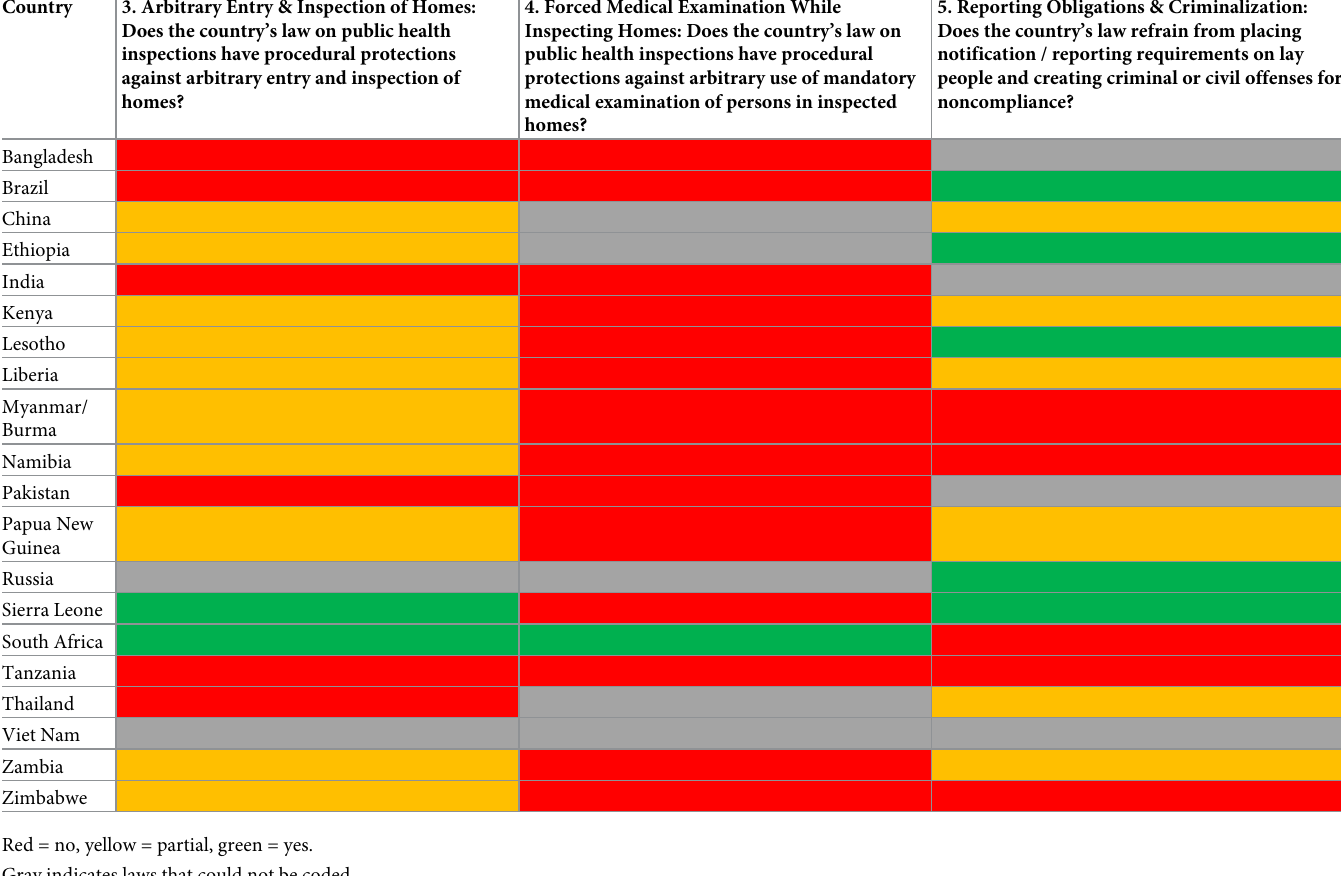
Table 2. TB-related laws on privacy.